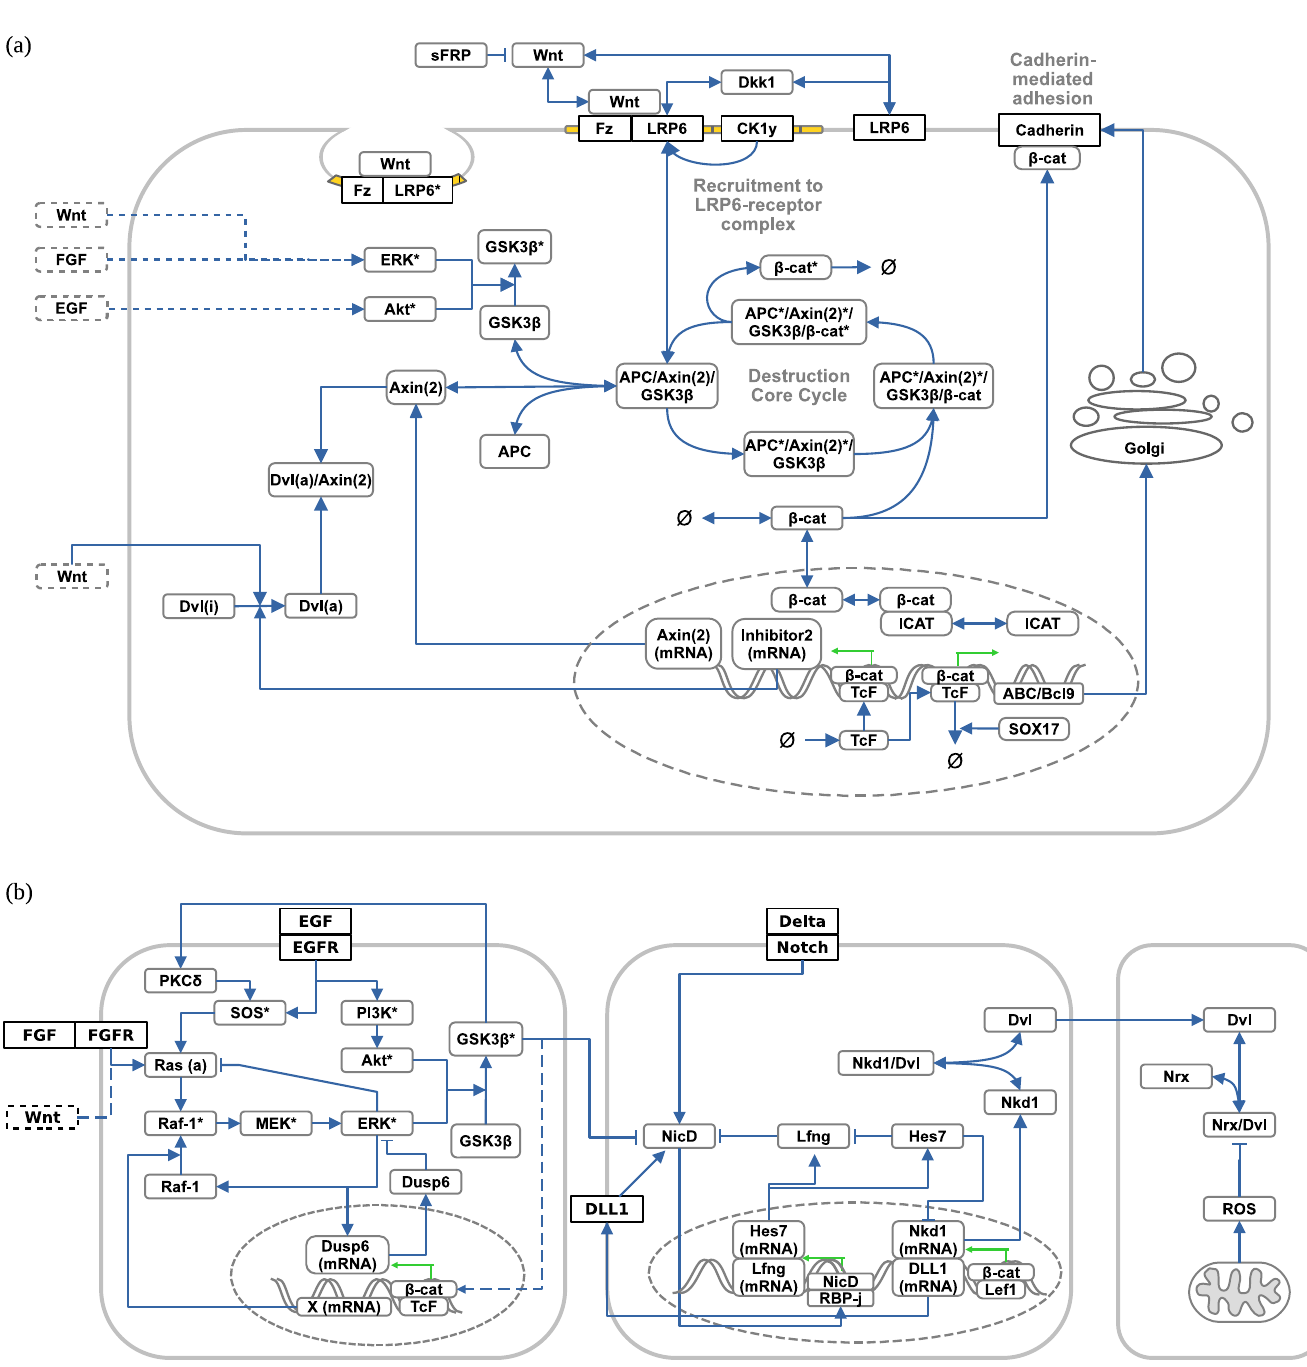
Fig 1. Combined overview of all qualitative Wnt (sub-)models found within the 19 Wnt simulation studies. Depicted are the components (species, compartments, and reactions) of the canonical Wnt signaling pathway (a) and its crosstalk with other signaling pathways (b) found within the 19 Wnt simulation studies. Note that the overview is a simplified and condensed representation. Interactions are simplified and some components of the submodels that do not directly affect the Wnt signaling pathway are omitted. Activated/phosphorylated proteins are indicated by ( � ). Inactive/unphosphorylated states of proteins have been omitted when possible. Submodels involving membrane-mediated processes, such as receptor/ligand interactions, destruction complex recruitment and endocytosis [31, 45, 51, 56], or cadherin-mediated cell adhesion [34, 39, 49] are incorporated in (a). Submodels involving crosstalk with ERK/FGF/PI3K/Akt [32, 36, 53], Notch [33, 36, 48], and ROS/ Dvl-mediated pathways [51, 57] are shown in the lower panels of (b), respectively.